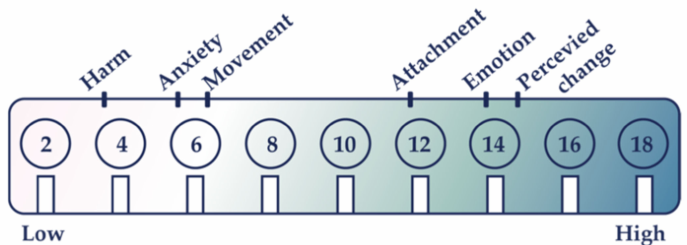
Figure 11. The mean values of the six elements of comfort rating scales for